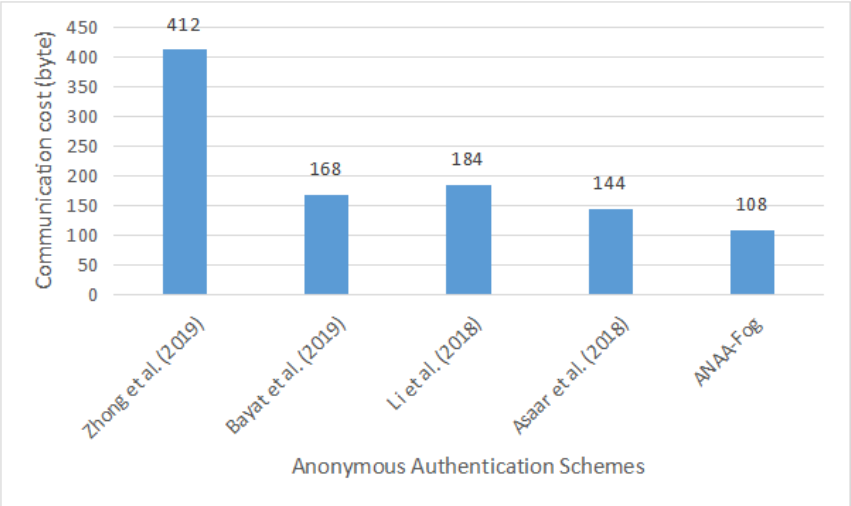
Figure 8. Verification communication overhead for authentication